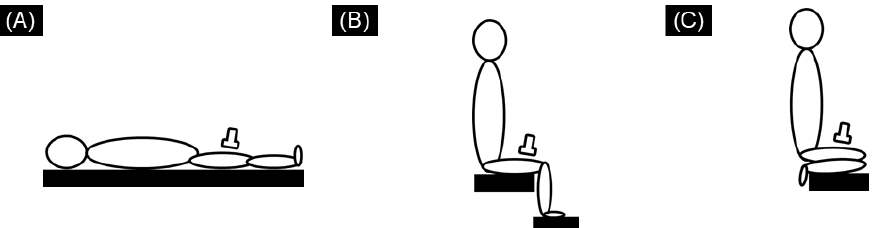
Figure 1. Schematic representation of the subject’s posture for ultrasound shear wave elastography (SWE) measurement. The vastus lateralis (VL) shear modulus was measured at the following three different knee joint angles: knee full extension in the supine position ( A ), 90° of knee flexion in the seated position ( B ), and knee full flexion in the seated position (with the right heel in contact with the hip) ( C ).